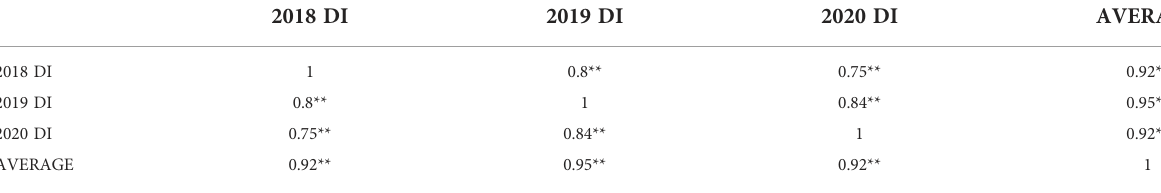
TABLE 1 Correlation coef fi cients among the three trial environments for the sharp eyespot disease